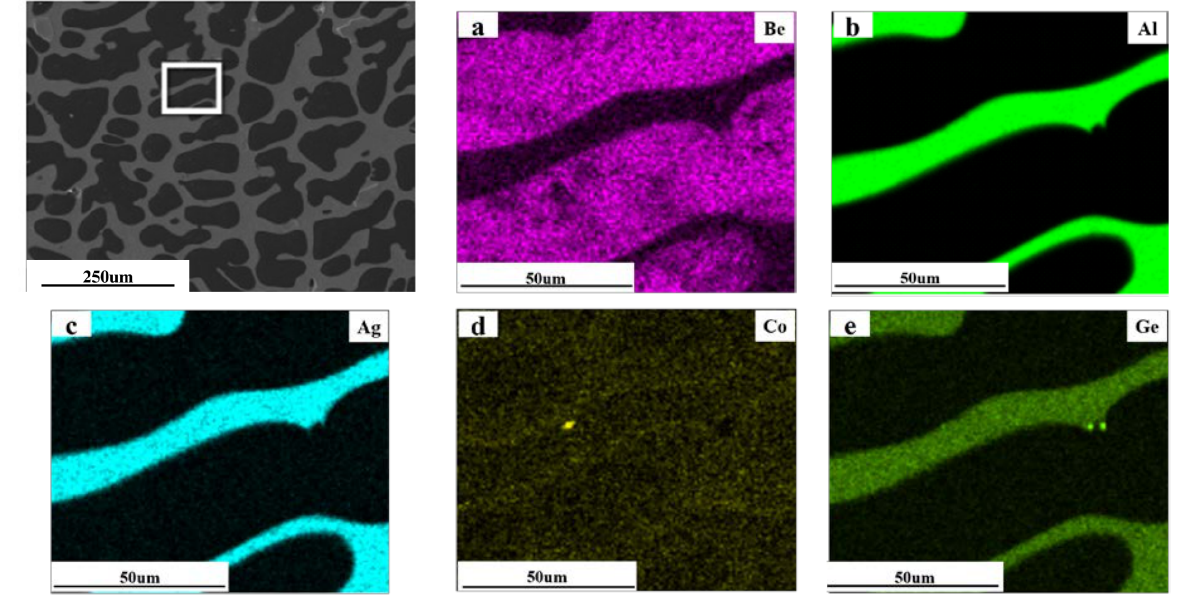
Figure 4. Mappings of different elements in Be-Al alloy ( a ) Be, ( b ) Al, ( c ) Ag, ( d ) Co and ( e ) Ge [32].